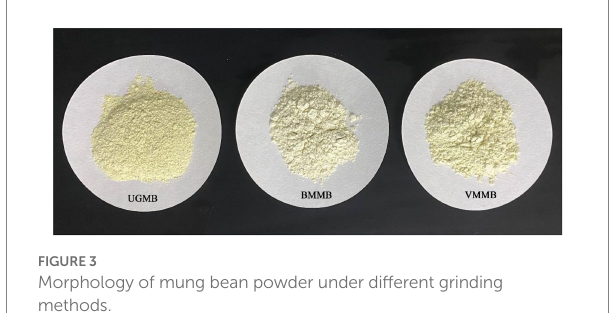
FIGURE 3 Morphology of mung bean powder under different grinding methods.